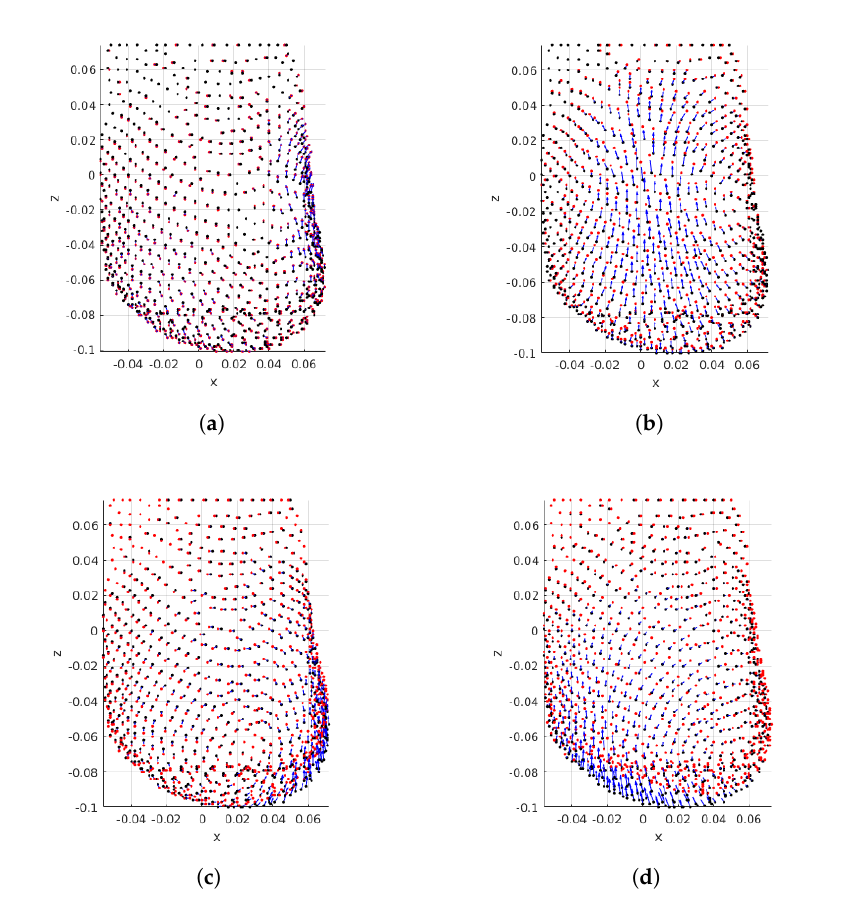
Figure 11. Influence of tumor position on deformations: PCLs are shown for the same patient with the tumor positioned in different breast quadrants/regions. Largest tumors are shown for BI-RADS A. Pre- and post-surgical data on black and red, respectively. Blue arrows indicate displacement direction